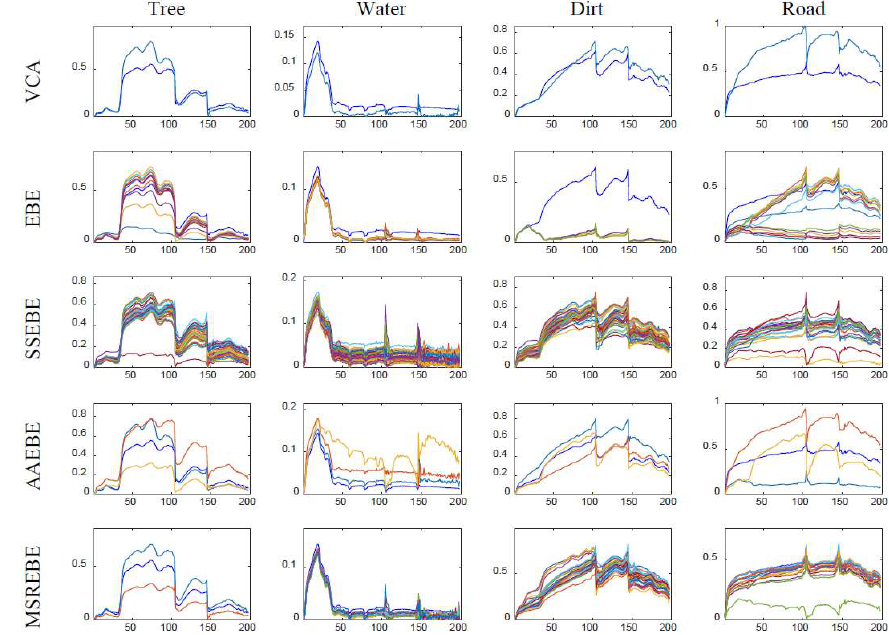
Figure 12. The endmember extraction results of Jasper Ridge dataset. Table 3. Experimental results of Jasper Ridge dataset.